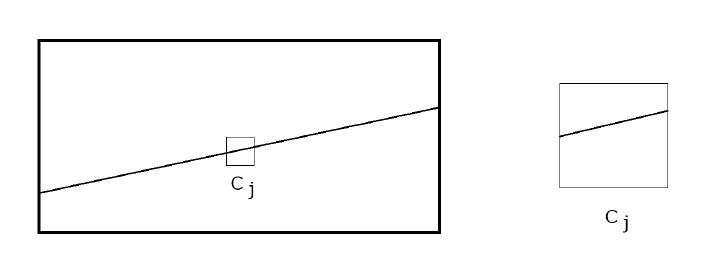
Figure 3. First step of the reiterating